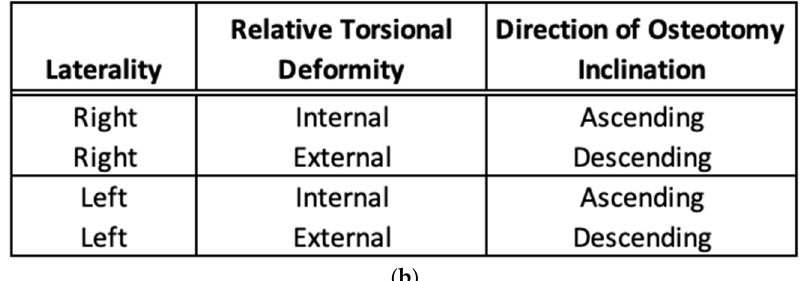
Figure 6. ( a ) The wrong orientation (ascending or descending) of the osteotomy plane will worsen a rotational deformity rather than correct it. To confirm the appropriate osteotomy position, Paccola developed a simple table to determine the appropriate direction of the osteotomy inclination. This is visualized on the no deformity view. The center of rotation of the osteotomy plane is located at the apex of the deformity in the center of the bone. ( b ) Modified from Paccola, this table can be used to verify the appropriate osteotomy plane inclination. It takes into account the limb laterality and the relative torsional deformity to be corrected [23].